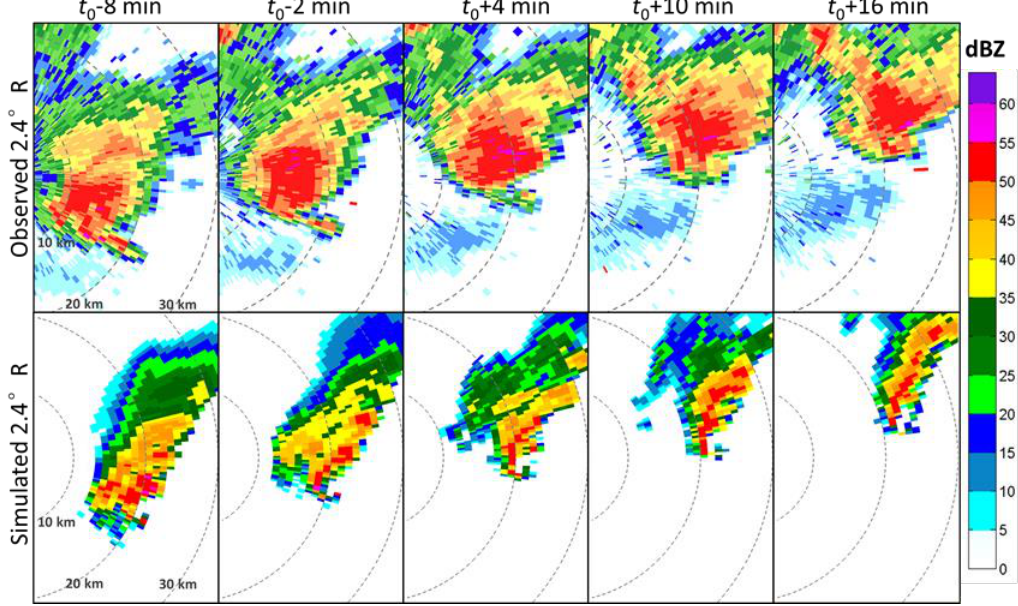
Figure 2. Two-dimensional comparison between observed (upper row) and simulated (lower row) supercells in terms of basic reflectivity (R) at 2.4 ◦ elevation angle contours at five scanning times. The ranges at 10, 20 and 30 km are given by concentric circles centered on the radar site.